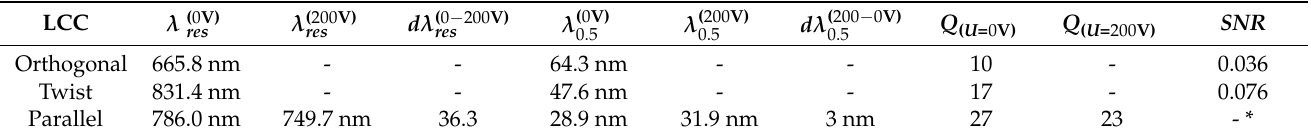
Table 1. Resonant dips obtained for LC cells with the gold monolayers [14].